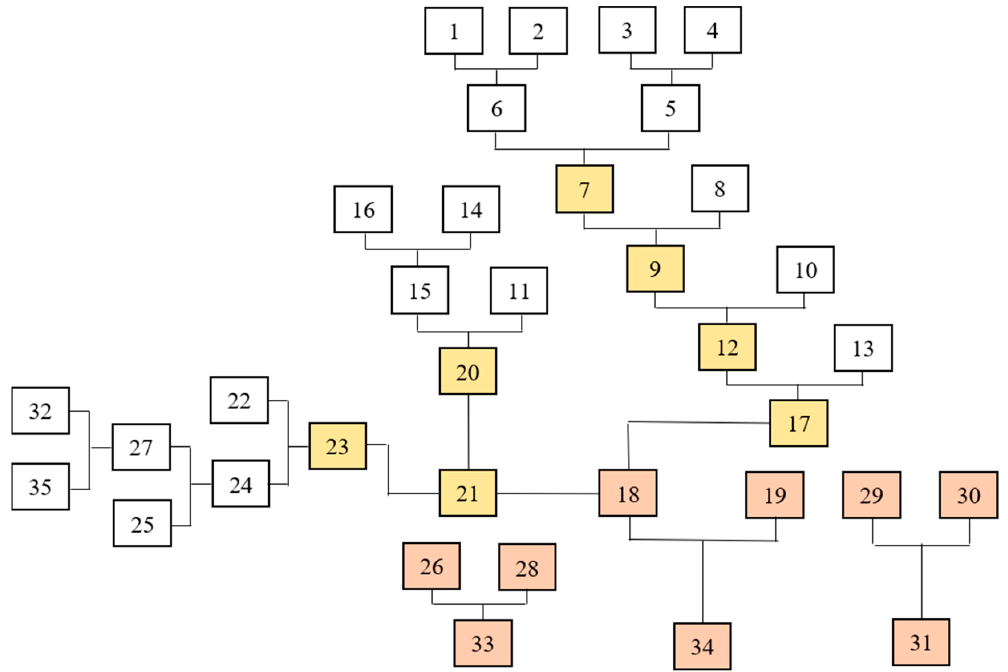
Figure 3. The topological relationship among the 35 sub-basins. The white boxes are upstream in the river water system, whereas those in yellow are in the middle parts, and those in red are down- stream.